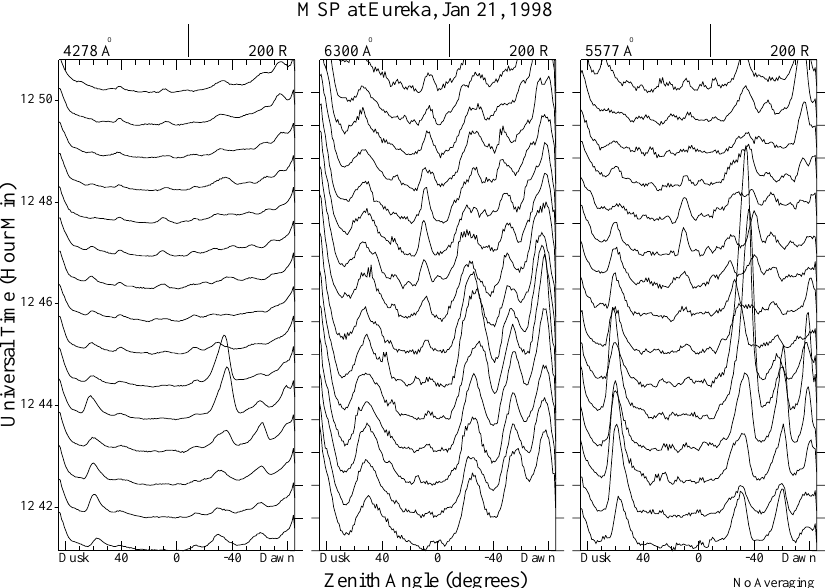
Fig. 11. Plots of MSP scans from 1241 to 1251 UT on January